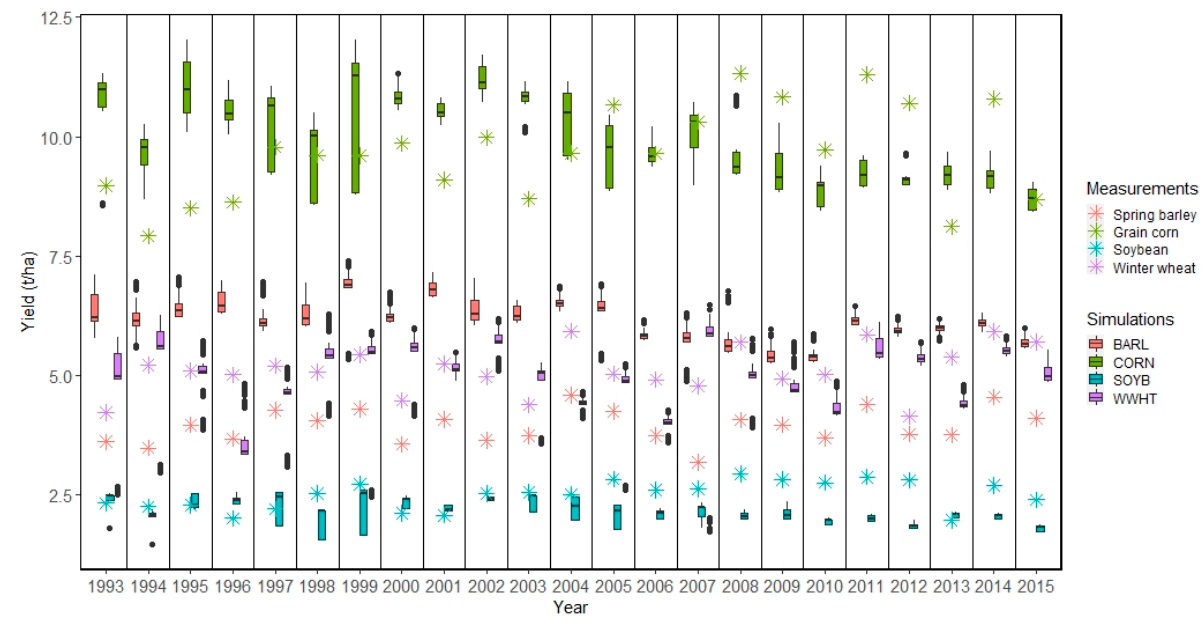
Figure 4. Measured and simulated crop yields at the HRU level in the Melk catchment for M1 setup. The SWAT simulated crops BARL (spring barley), CORN (grain corn), SOYB (soybean), and WWHT (winter wheat) refer to Table S2.